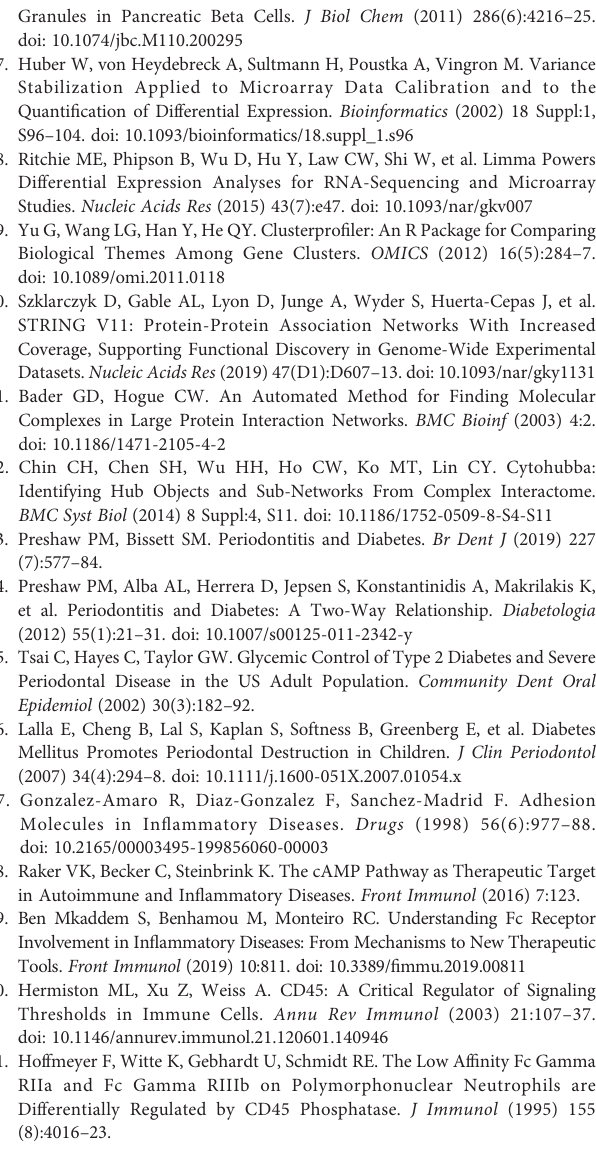
Supplementary Figure 4 | The results of ROC analysis for hub genes in periodontitis patient samples. (A) RAC2, (B) INPP5D, (C) PTPRC, (D) HGF. Supplementary Figure 5 | The results of ROC analysis for hub genes in periodontitis with diabetes patient samples. (A) RAC2, (B) INPP5D, (C) PTPRC, (D) HGF. Supplementary Table 3 | The results of GO and KEGG pathway